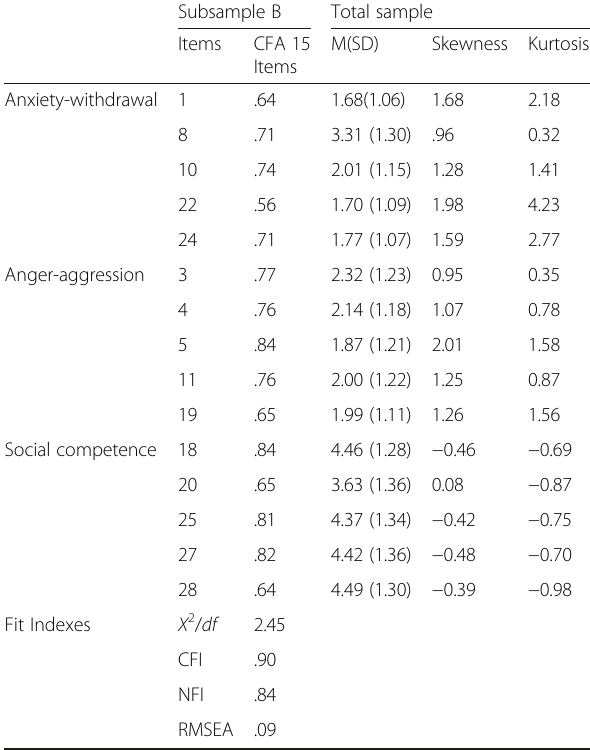
Table 2 Factor loadings (CFA) in subsample B, and descriptive statistics for the total sample